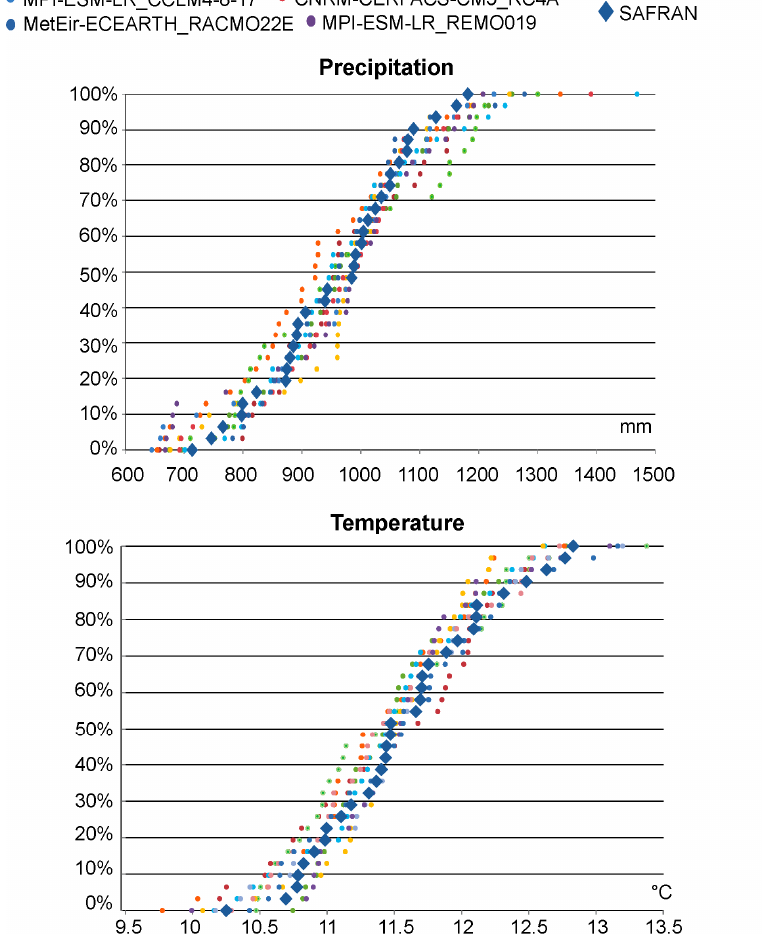
Figure 3. Comparison of yearly precipitation and average temperature climatic ensembles (historical period) against the SAFRAN dataset. (Names as